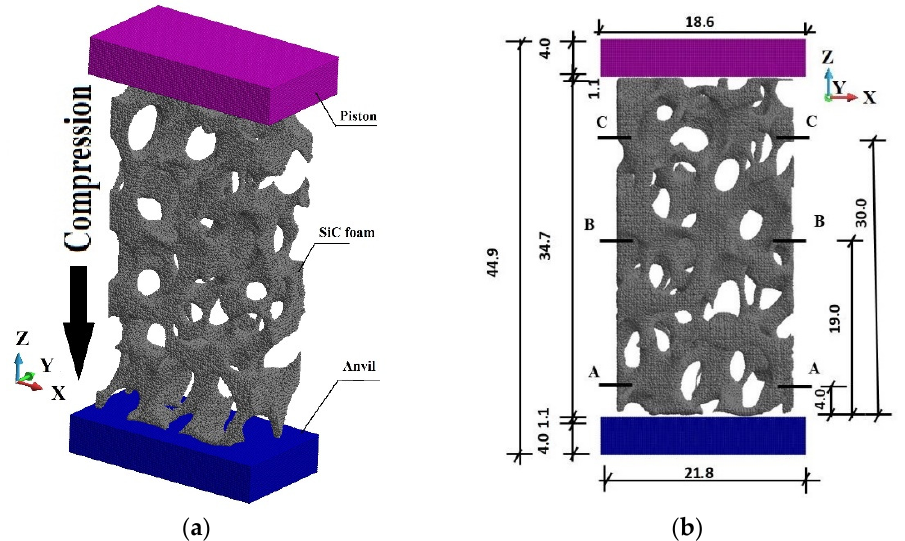
Figure 5. The PD discretized system, SiC foam placed between piston and anvil (mm): ( a ) Axonometric view; ( b ) Plane view.